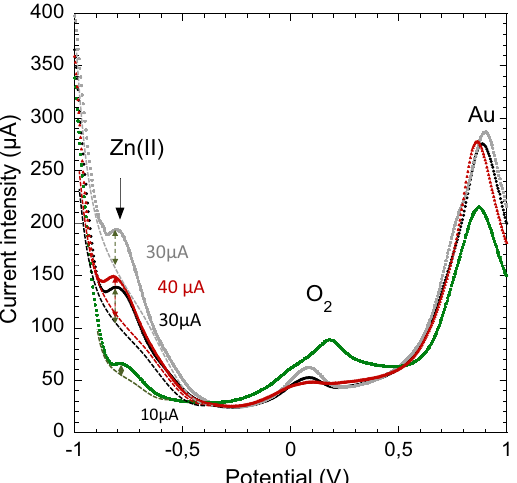
Figure 9. Square-wave anodic stripping voltammograms obtained using a PAA-g-PVDF membrane-electrode in 80 mL of: (1) raw production waters (grey and black curves—duplicate experiments); (2) a presorbed production water which was already in contact for 30 min with a PAA-g-PVDF membrane-electrode (green curve); (3) a 1 ppm Zn(II) spiked presorbed production water (red curve).